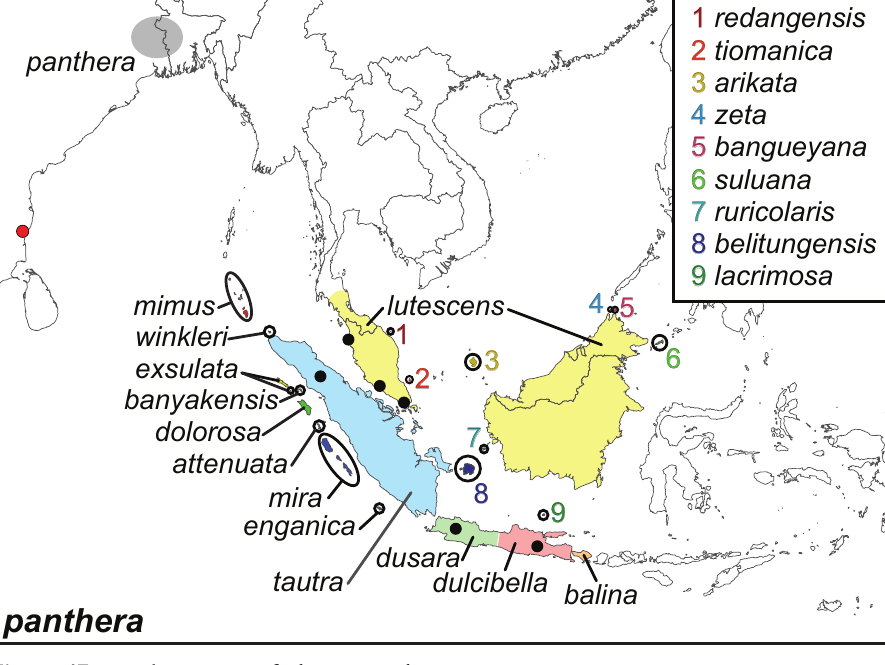
Figure 47. Distribution map of Elymnias panthera .